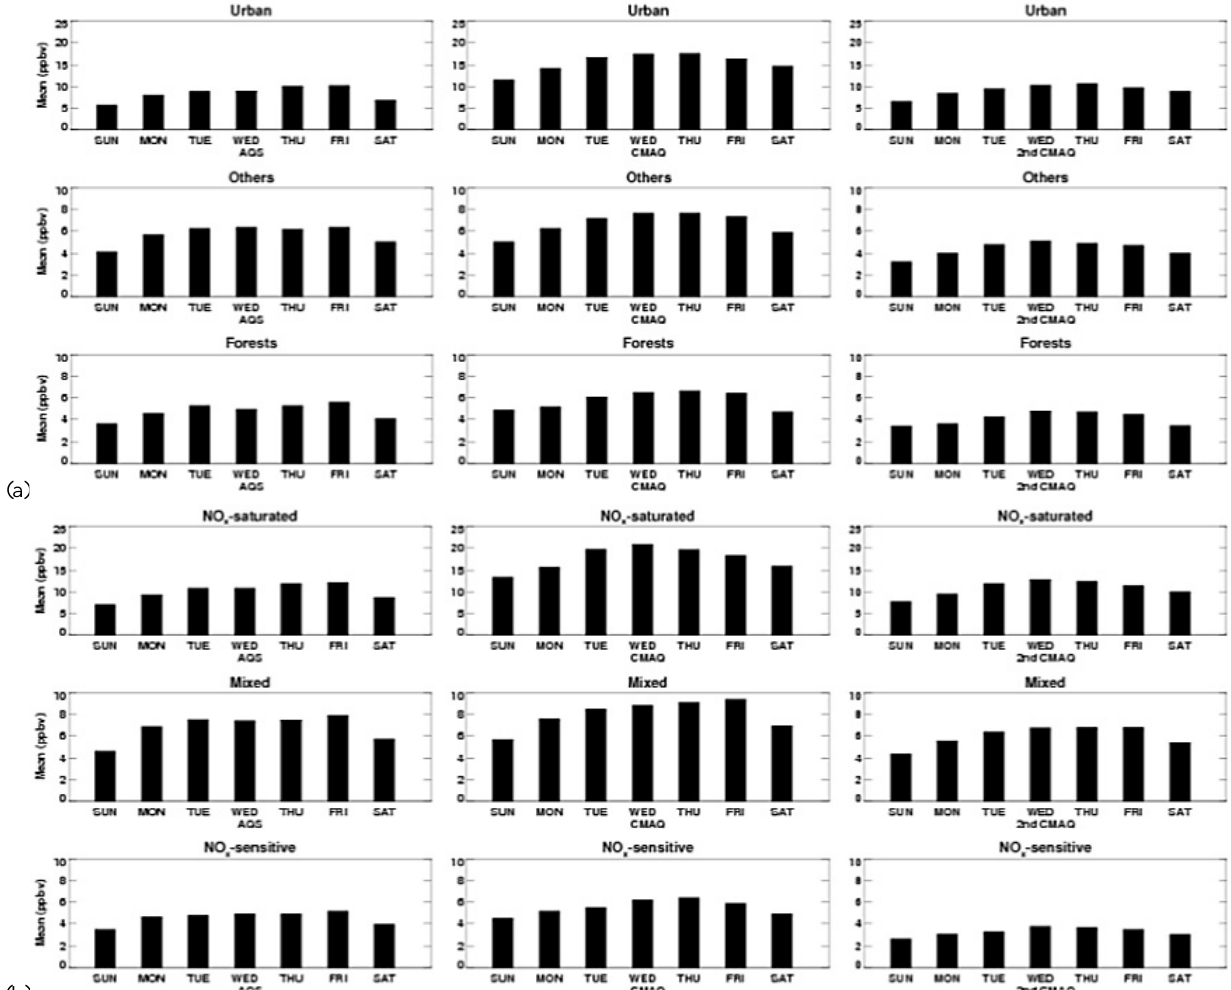
Fig. 10. (a) Weekly mean variations of AQS-observed, CMAQ-simulated, and the 2nd CMAQ-simulated (with GOME-2-derived emissions inventory) ground-level NO x concentrations at EPA AQS stations over AVHRR-derived geographical regions (i.e., urban, other, and forest regions) for August 2009. For the sake of consistency with the daytime O 3 comparison in Fig. 7, only daytime (01:00–05:00p.m., local time) NO x concentrations are used; some data are filtered out from 17–19 August 2009, when Tropical Storm Ana strongly affected air quality over the eastern US. Note that the index of the vertical y-axis for the urban region stations (0–25ppbv) differs from the indices (0–10ppbv) of other and forest region stations. (b) Same as in (a) , but over GOME-2-derived chemical regimes (i.e., NO x -saturated, mixed, NO x -sensitive regimes). Note that the index of the vertical y-axis for NO x -saturated regime stations (0–25ppbv) differs from the indices (0–10ppbv) of mixed and NO x -sensitive regime